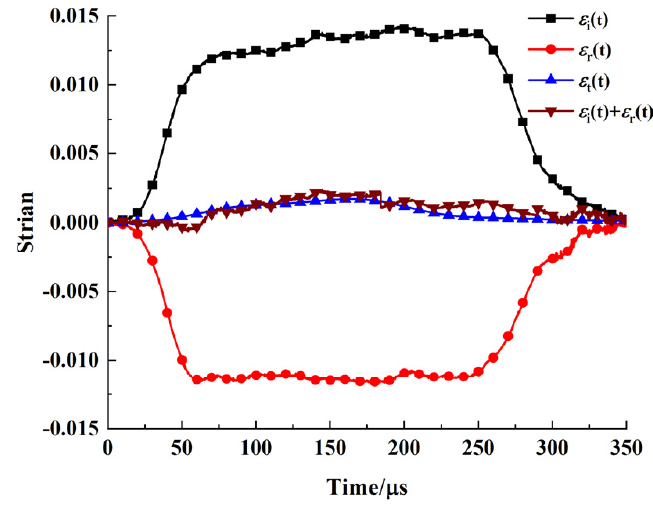
Figure 4. Stress equilibrium diagram.